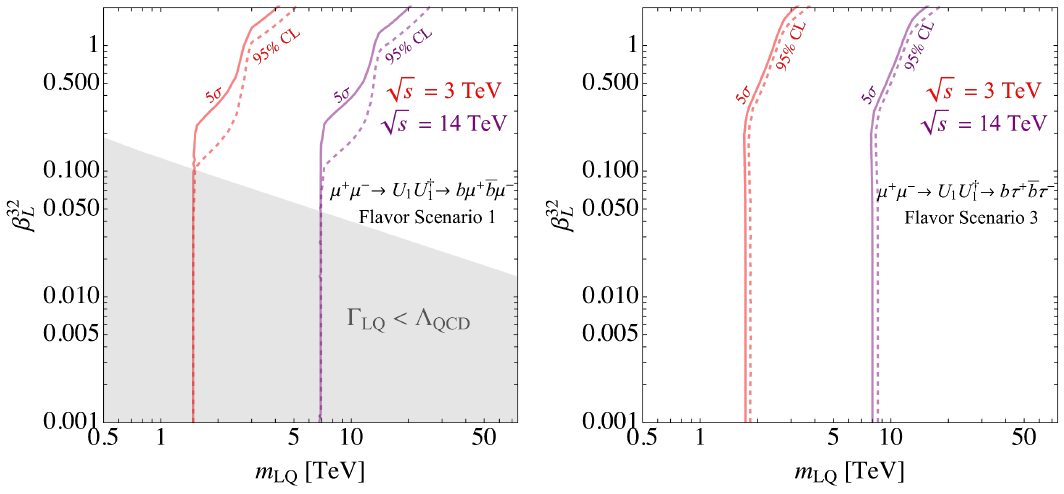
Figure 5 . Contour plots of the 95% CL (dashed) and 5 σ discovery (solid) for pair production of √ LQ at s = 3 , 14 TeV. We show the reach for flavor scenario 1 (left) and flavor scenario 3 (right). In the gray region, the LQ lifetime is longer than Λ − 1 and non-perturbative hadronization effects QCD will have to be included for a more accurate result. For sufficiently small couplings the production cross section is dominated by the electroweak production and the bounds become independent of the LQ coupling to the muons.